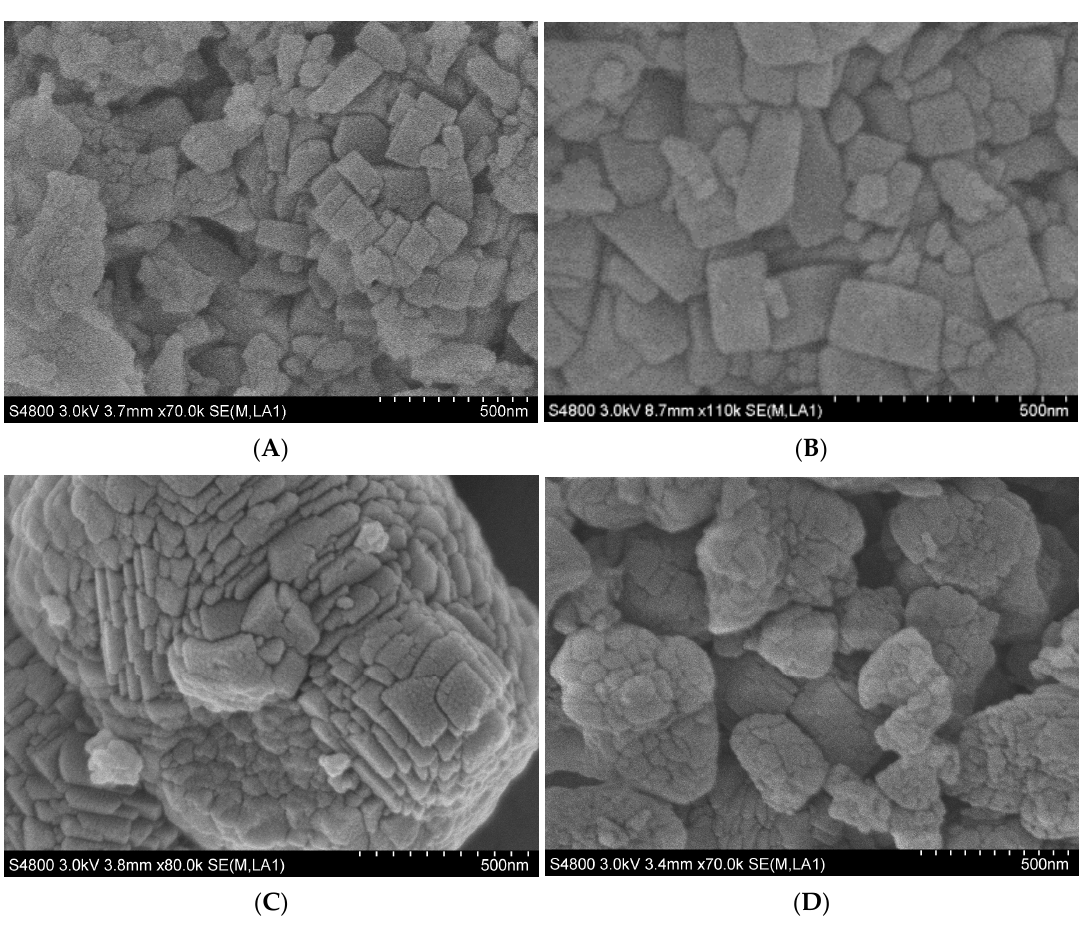
Figure 5. SEM images of untreated and treated HZSM-5. PZ30 ( A ); Z30.2 ( B ); PZ80 ( C ); and Z80.2 ( D ).